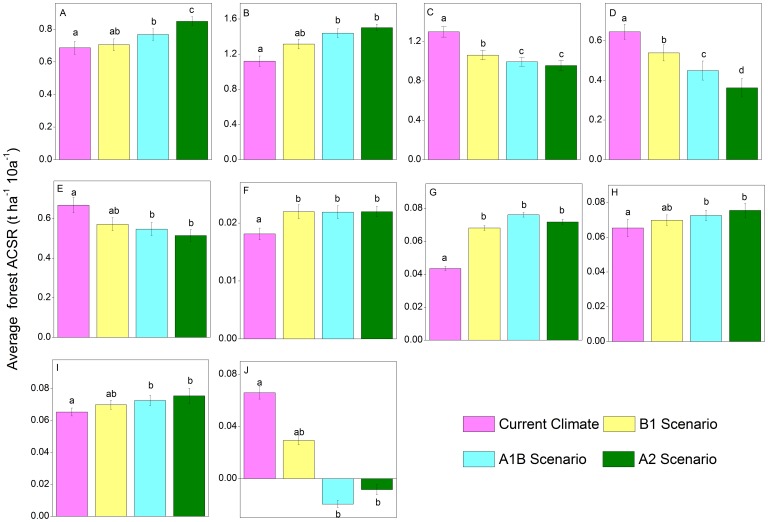
Results of multiple comparisons of the influences on species aboveground carbon sequestration rate.A: Korean pine in 2060–2100, B: Korean pine in 2160–2200, C: Spruce in 21260–2200, D: Khingan fir in 2160–2200, E: Larch in 2160–2200, F: Amur cork in 2060–2100, G: Amur cork in 2160–2200, H: Mongolia oak in 2160–2200, I: Black birch in 2060–2100, and J: Black birch in 2160–2200.